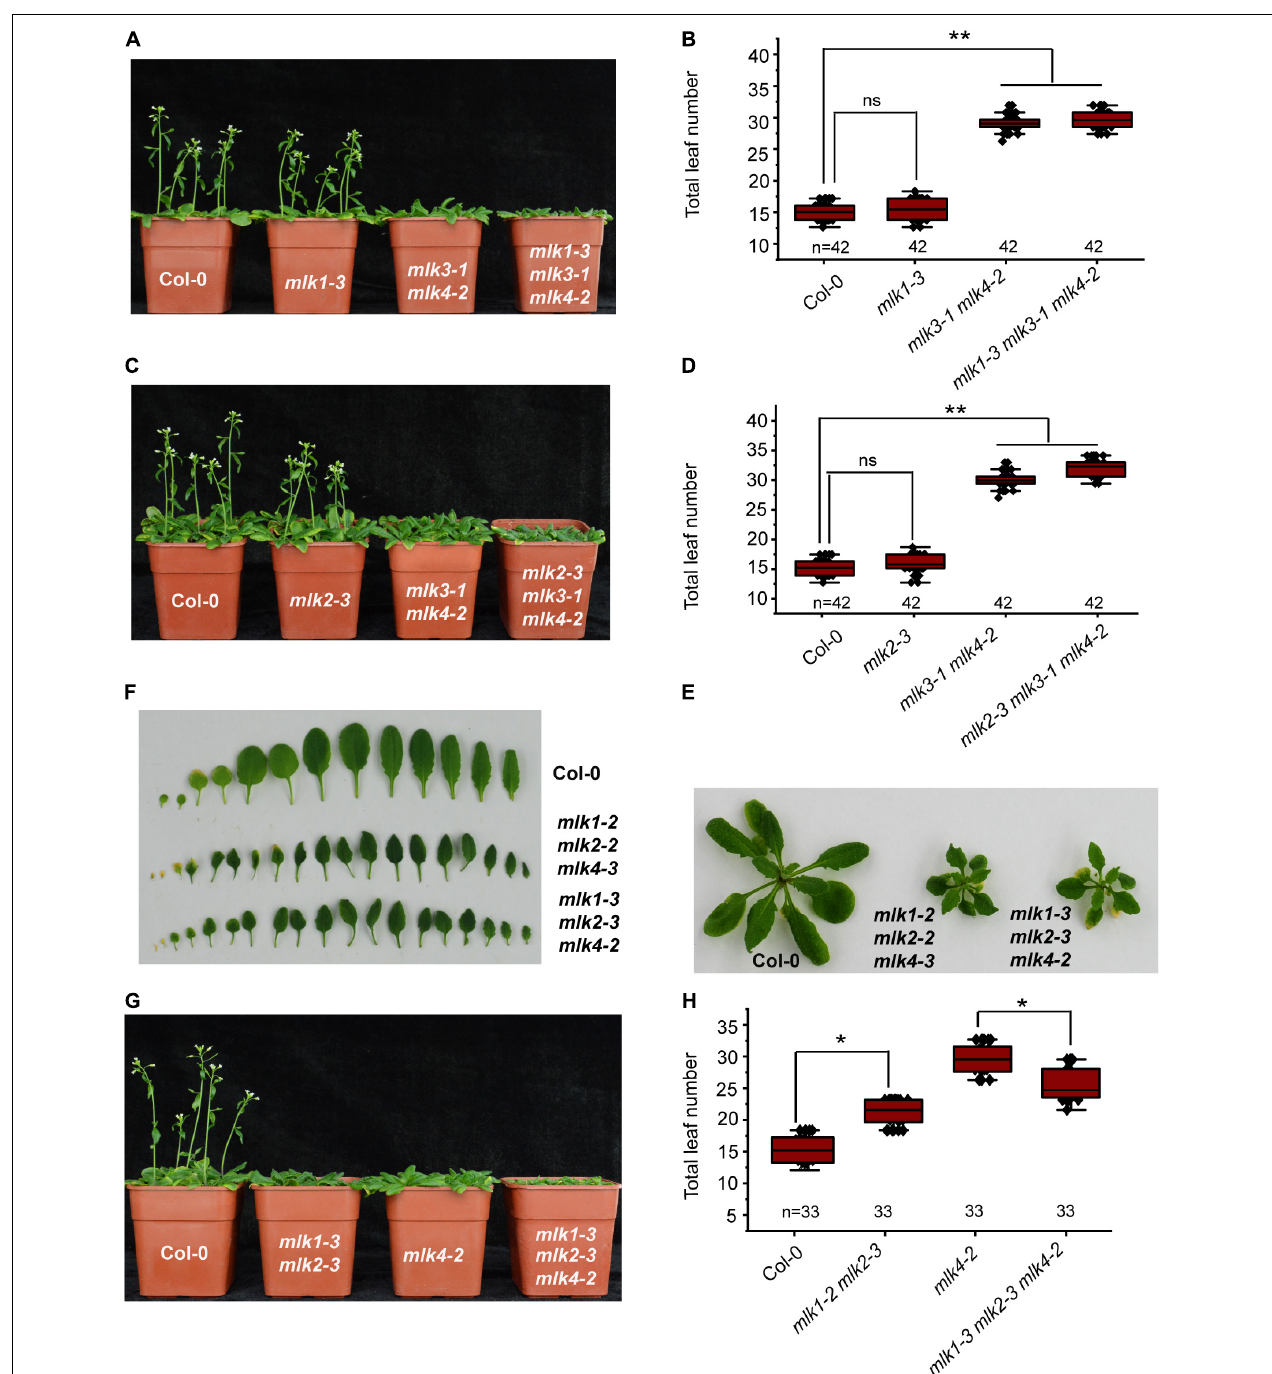
FIGURE 3 | Loss of MLK1 , MLK2 , and MLK4 function resulted in growth defects. (A) The representative phenotype of Col-0, mlk1-3 , mlk3-1 mlk4-2 , and mlk1-3 mlk3-1 mlk4-2 plants under a LD photoperiod. (B) The total leaf number of Col-0, mlk1-3 , mlk3-1 mlk4-2 , and mlk1-3 mlk3-1 mlk4-2 mutants under a LD photoperiod. Values shown are mean ± SD of total leaves; 33 plants were scored for each line. Asterisks indicate P < 0.01 and ns indicates no significance by t -test. (C) The representative phenotype of Col-0, mlk2-3 , mlk3-1 mlk4-2 , and mlk2-3 mlk3-1 mlk4-2 plants under a LD photoperiod. (D) The total leaf number of Col-0, mlk2-3 , mlk3-1 mlk4-2 , and mlk2-3 mlk3-1 mlk4-2 mutants under a LD photoperiod. Values shown are mean ± SD of total leaves; 33 plants were scored for each line. Asterisks indicate P < 0.01 and ns indicates no significance by t -test. (E) The 3-week old mlk1-3 mlk2-3 mlk4-2 triple mutants exhibit the dwarf phenotype. (F) The representative leaves from 3-week old mlk1-3 mlk2-3 mlk4-2 plants are shown. (G) The representative phenotype of Col-0, mlk1-3 mlk2-3 , mlk4-2 , and mlk1-3 mlk2-3 mlk4-2 plants under a LD photoperiod. (H) The total leaf number of Col-0, mlk1-3 mlk2-3 , mlk4-2 , and mlk1-3 mlk2-3 mlk4-2 mutants under a LD photoperiod. Values shown are mean ± SD of total leaves; 33 plants were scored for each line. Asterisks indicate P < 0.05 by t -test.